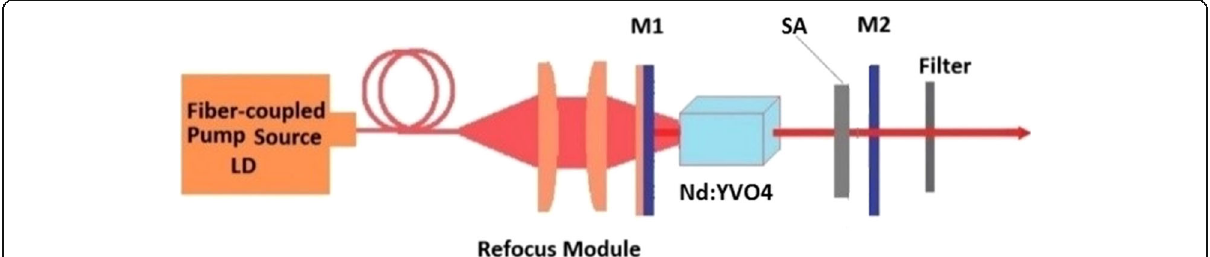
Fig. 3 Schematic of the Q-switching laser cavity